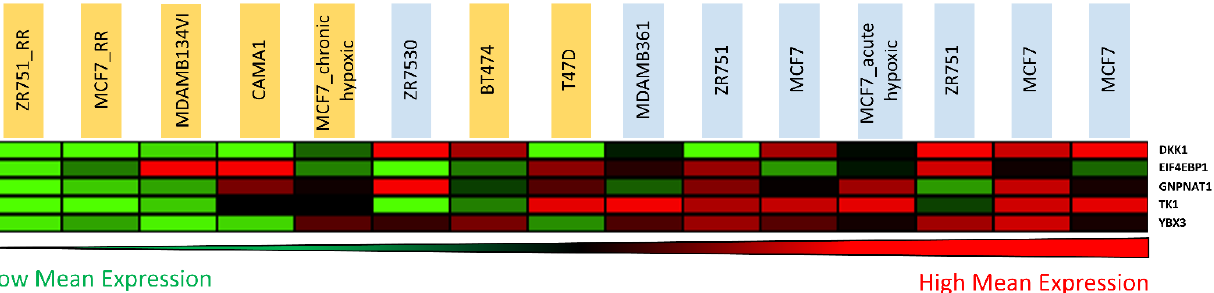
Figure 7. Candidate biomarker expression and intrinsic sensitivity to radiation. Mean-centred gene expression heatmap (red = higher expression, black = no change, green = lower expression) showing the levels of genes encoding the 5 lead candidate biomarkers, ranked left to right by highest mean expression, across a panel of ER + BC cell lines from a public dataset (GSE50811). SF2 values of parental and derived RR cells determined within our lab [29] were combined with SF2 values of a panel of ER + BC cell lines ascertained by others in the literature [19,54 – 57]. Cell lines with SF2 values <0.4 and >0.4 were classed as radiosensitive and RR, respectively [58]. The intrinsic radiosensitivity of individual cell lines is indicated by highlighted colour (blue = sensitive, yellow = resistant).